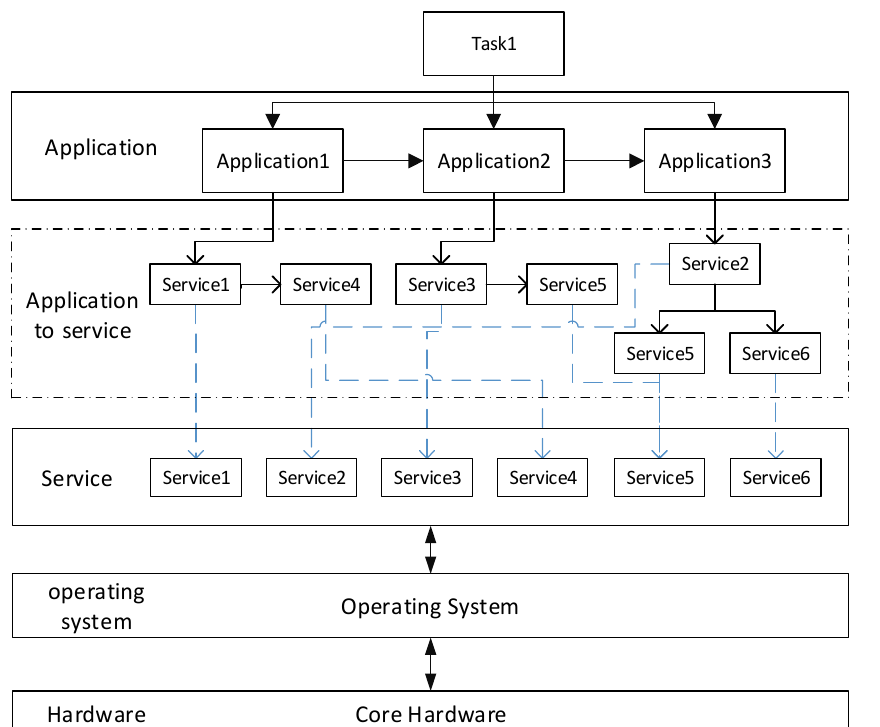
Figure 1. SOA working logic in avionics system.